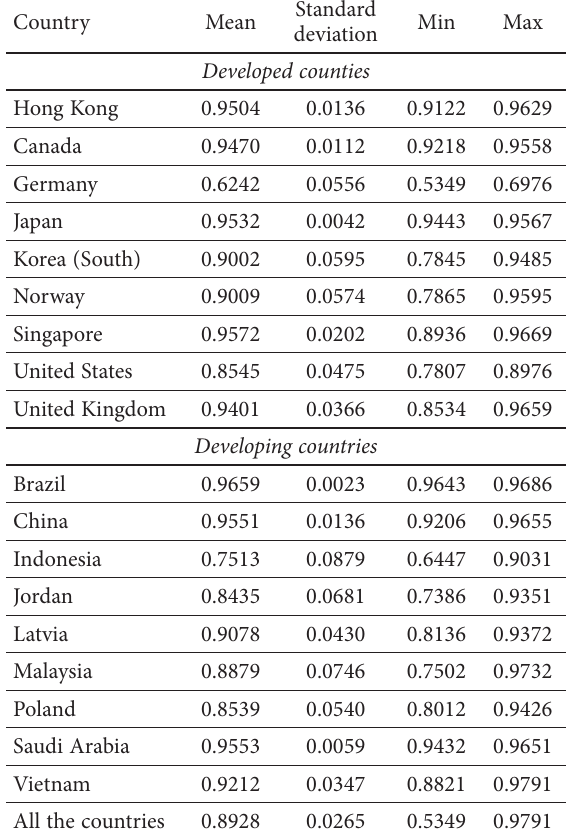
Table 5. Technical efficiency of public road transport by